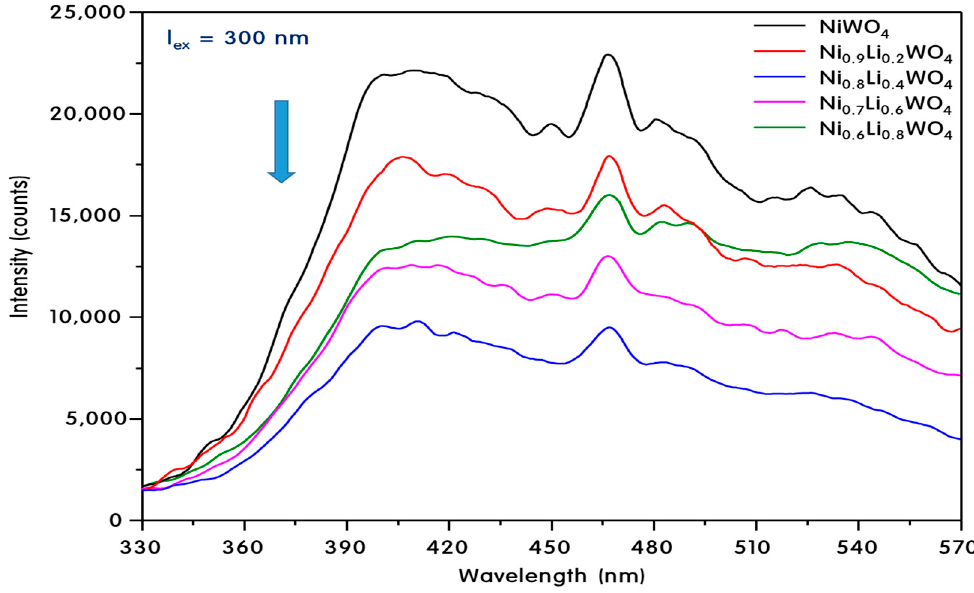
Figure 6. PL spectra of Ni 1-x Li 2x WO 4 particles.